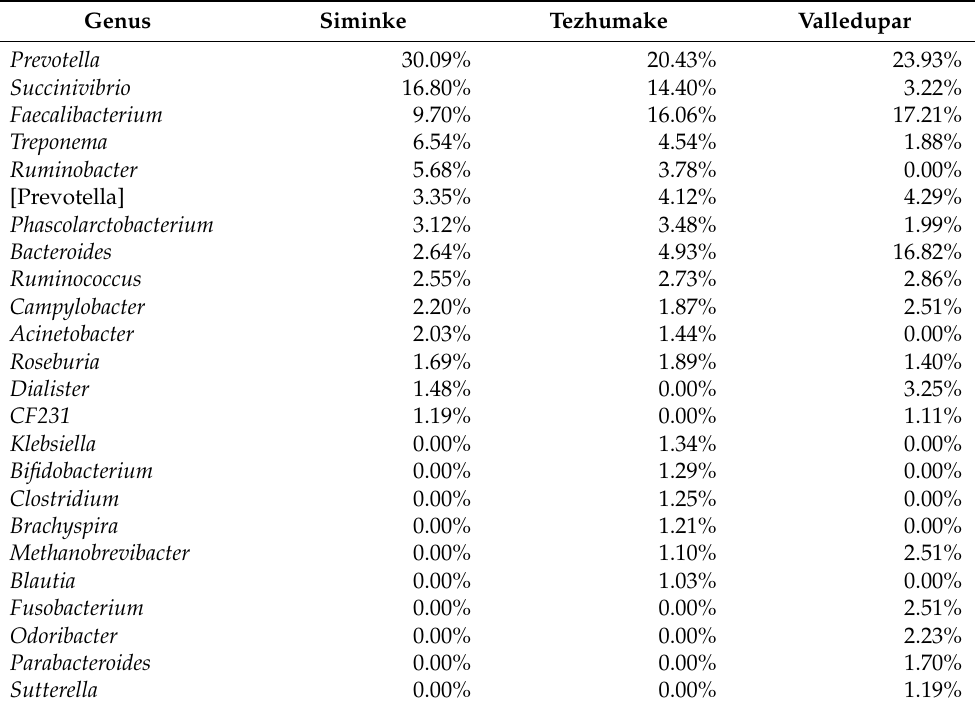
Table A2. Genera distribution in the three locations. Data indicate relative abundances (percentages of OTU counts). Genera with relative abundances lower than 1% were filtered out.